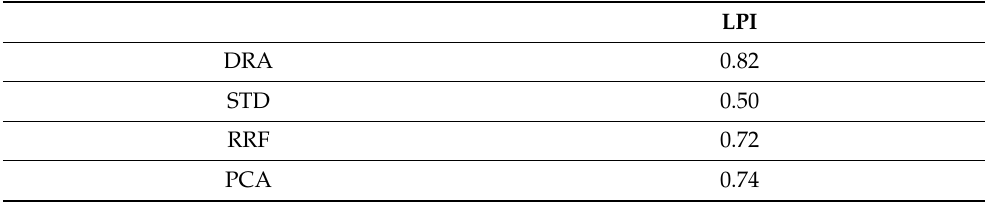
Table 2. Spearman correlation